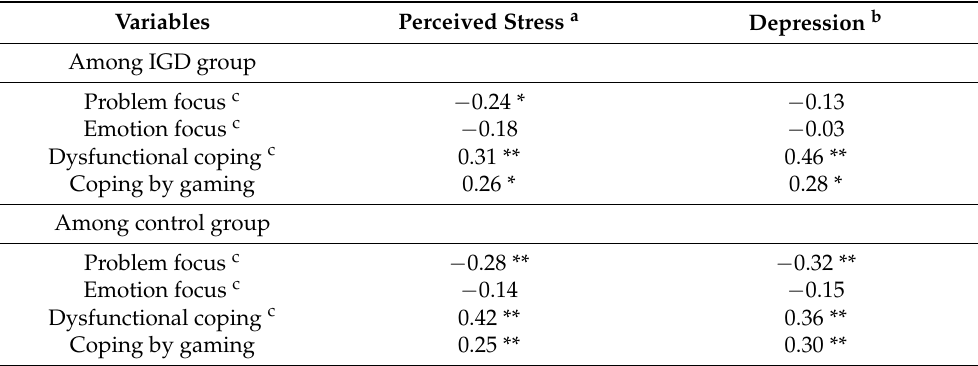
Table 6. Correlation between coping strategy, perceived stress, and depression among the internet gaming disorder (IGD) group and